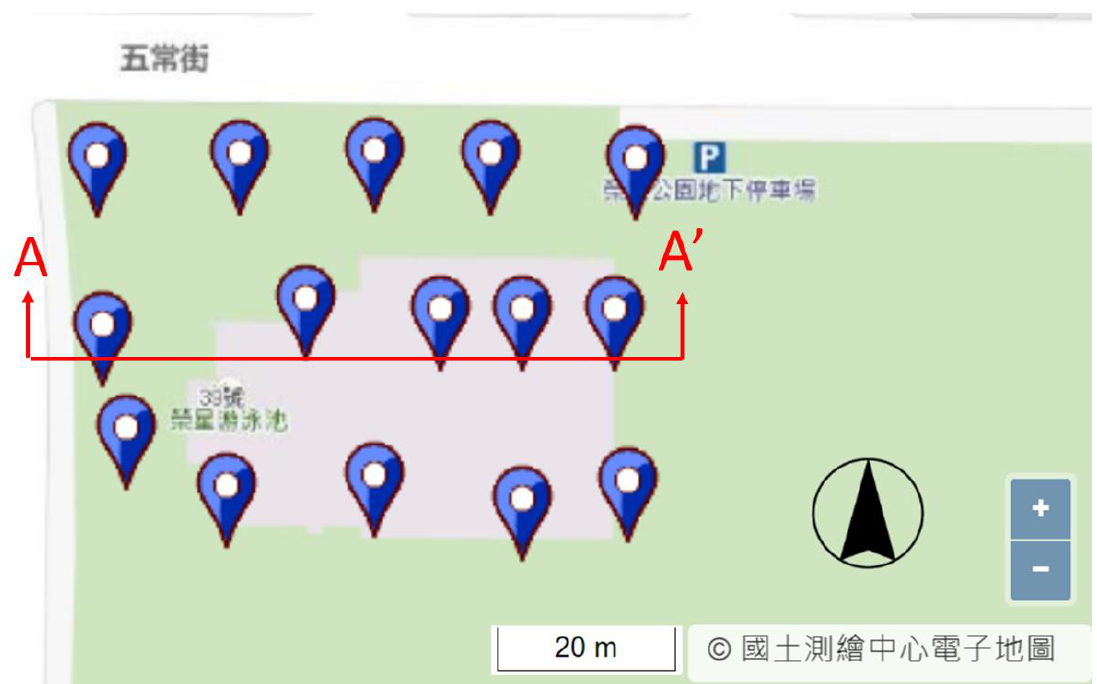
Figure 5. Schematic of the drilling locations at a construction site in northern Taiwan.